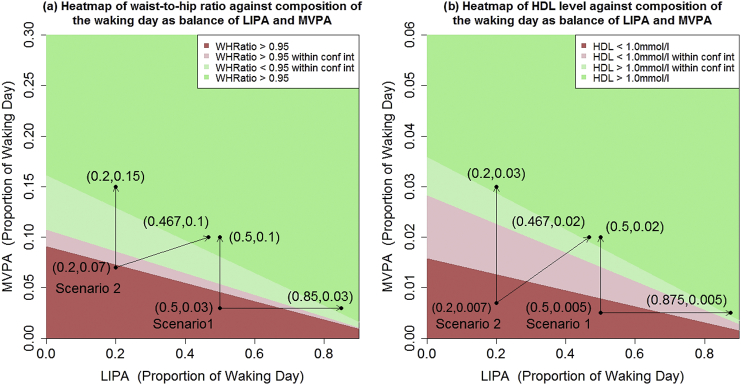
Expected (a) waist-to-hips ratio and (b) HDL cholesterol level against composition of the waking day according to balance of MVPA and LIPA, with the remaining proportion of the waking day made up of SB, for a male with degree level education, maximum daily alcohol consumption ≤ 4 units, no history of cardiovascular problems or stroke, not taking heart medicine and (a) aged 50 with no history of cancer, a previous diagnosis of diabetes, and living in a household where total income is under £2600pa; (b) aged 40 with no history of diabetes, or cancer, and living in a household where total income is under £2600pa. The pale regions referred to as within confidence interval are combinations of LIPA and MVPA where the 95% confidence interval for the expected outcome includes the threshold, either Waist-to-hip ratio = 0.95 or HDL = 1.0 mmol/L. Based on Health Survey for England 2008.